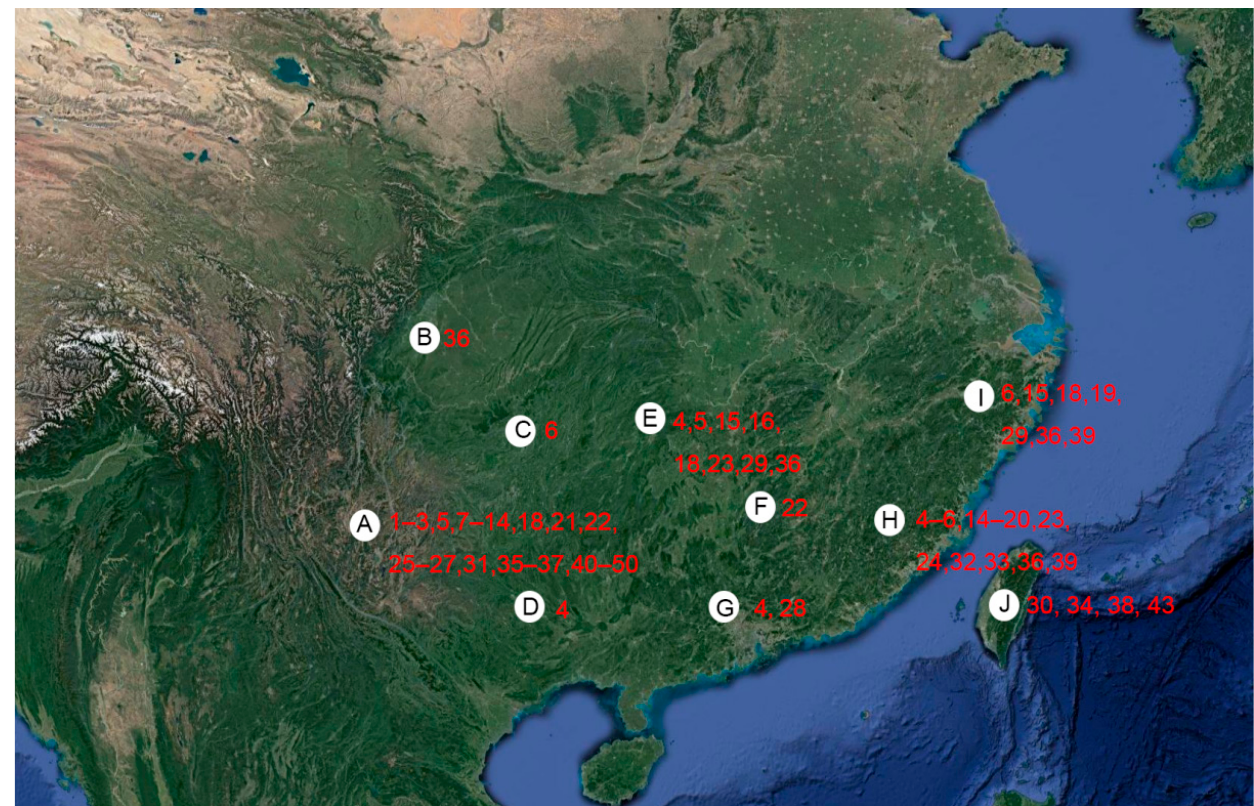
Figure 27. Geographical distribution of Singhardina species in China. As shown in the figure: ( A ) Yunnan Prov., ( B ) Sichuan Prov., ( C ) Guizhou Prov., ( D ) Guangxi Prov., ( E ) Hunan Prov., ( F ) Jiangxi Prov., ( G ) Guangdong Prov., ( H ) Fujian Prov., ( I ) Zhejiang Prov., ( J ) Taiwan Prov.; ( 1 ) E. ( S. )